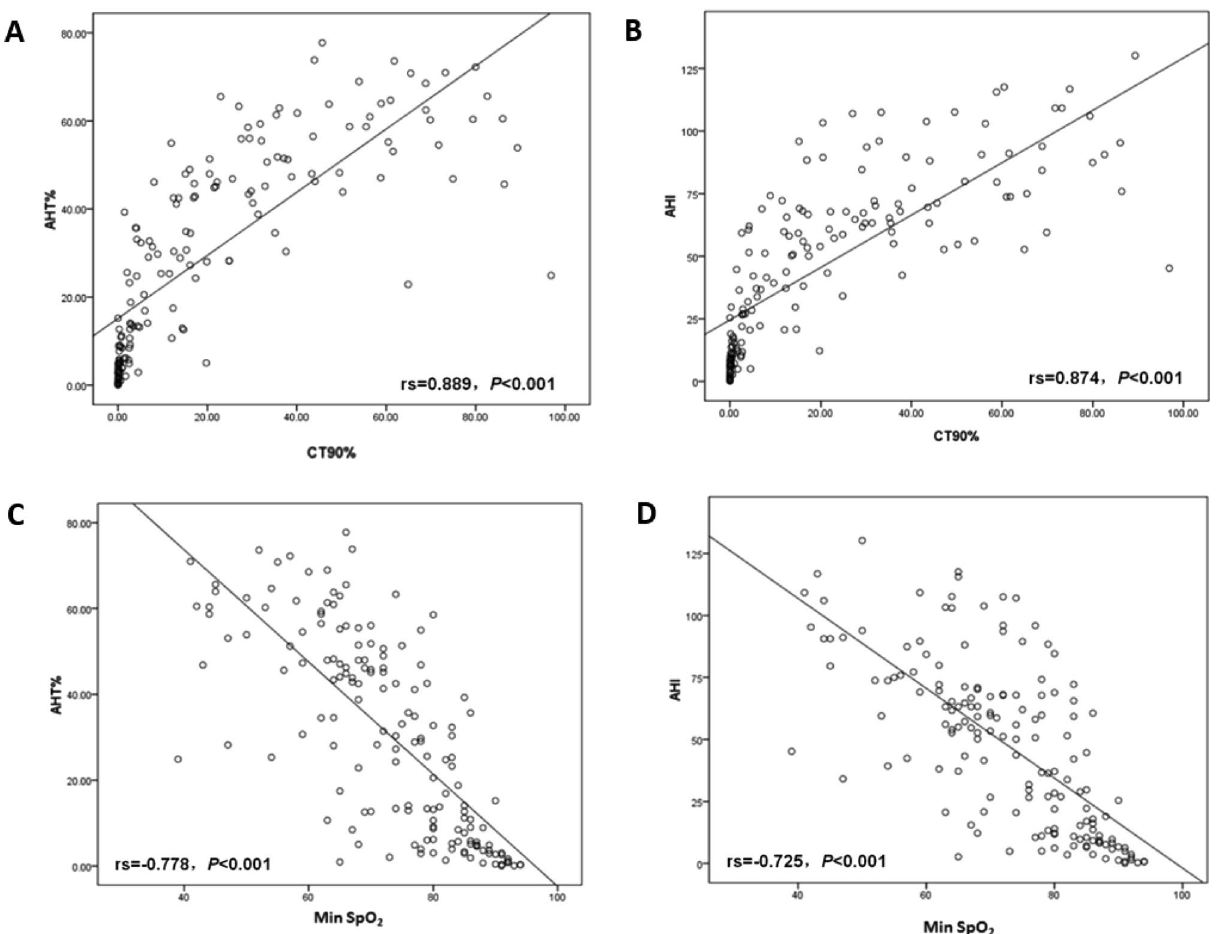
Figure 1. Correlation between AHT% and CT90% ( A ) and Min SpO 2 ( C ), correlation between AHI and CT90% ( B ) and Min SpO 2 ( D